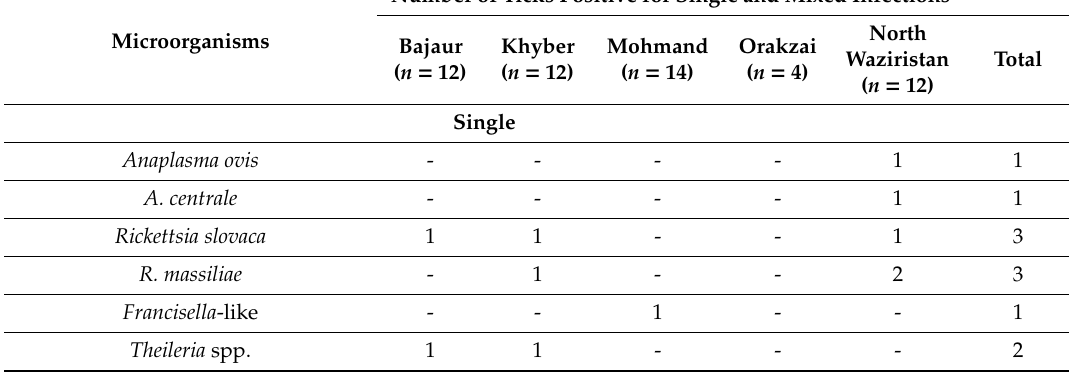
Table 4. Single and mixed presence of DNA of microorganisms in ticks of small ruminants in the FATA of Pakistan.